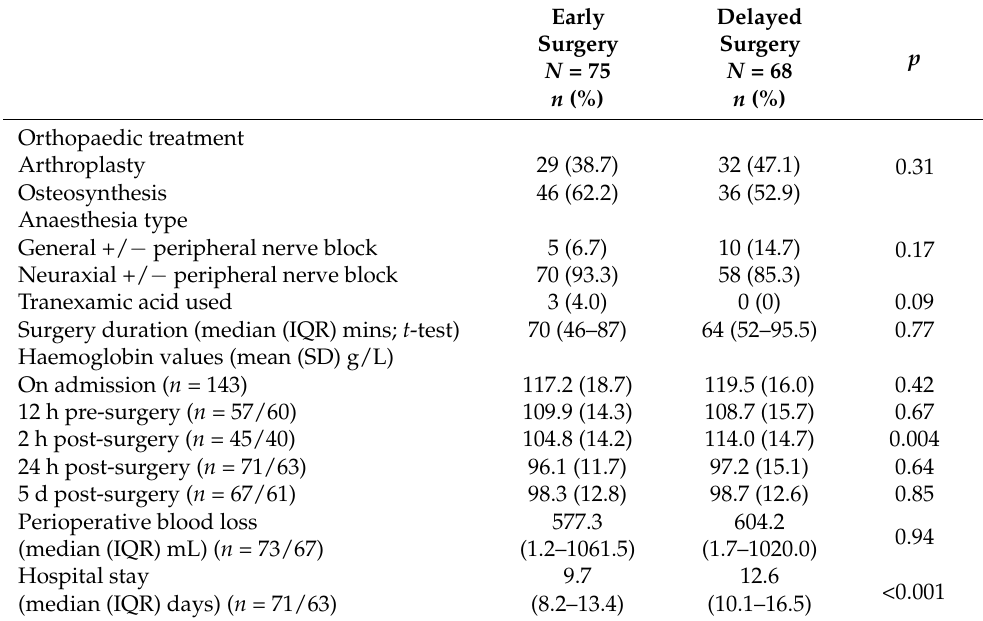
Table 3. Perioperative secondary outcomes.